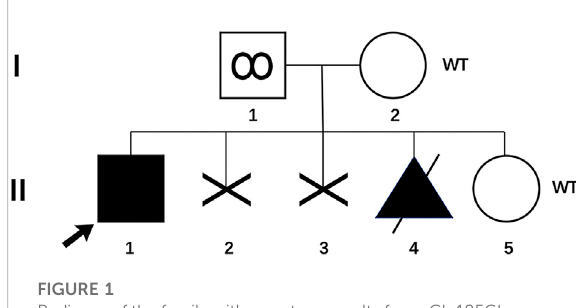
FIGURE 1 Pedigree of the family with genotype results for p . Gln185Glu variant. (I-1) Father with p . Gln185Glu variant in his sperm; (I-2) mother of the proband; (II-1) proband with p . Gln185Glu variant; (II-2 and 3) two aborted fetuses, unknown genotypes; (II-4) aborted fetus with p . Gln185Glu variant; (II-5) infant born through PGT-M. WT, wild